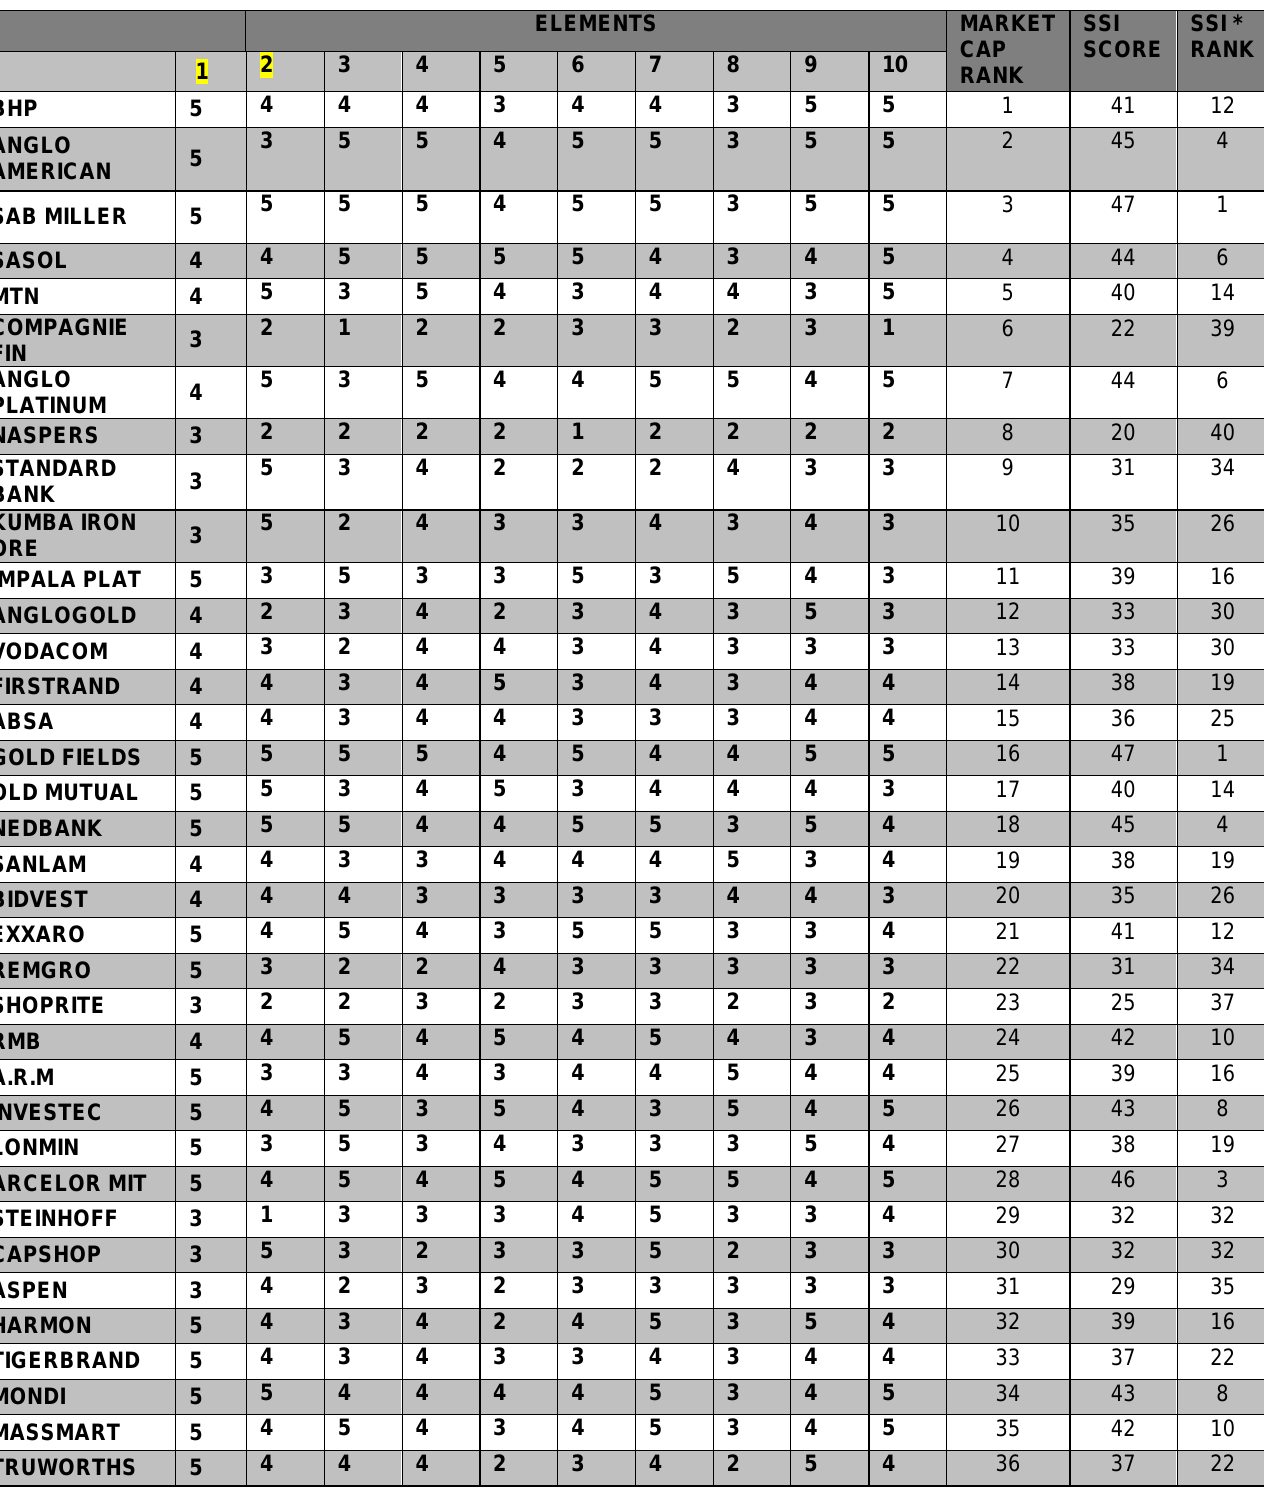
Table 3: Evaluation results of the Top 40 Companies based on the Strategising for Sustainability index (SSI) measurement tool, with individual elements and